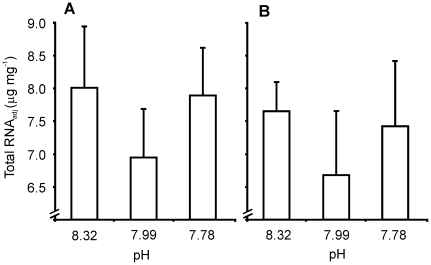

Laternula elliptica adductor tissue Total RNAadj
after A. 21 and B. 120 days at experimental pH.